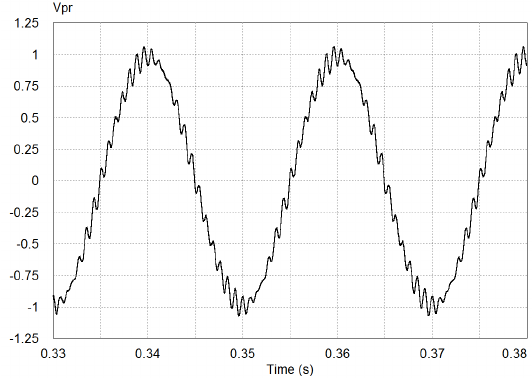
Figure 18. Steady-state primary voltage (Vpr) near resonance conditions originated by loss of